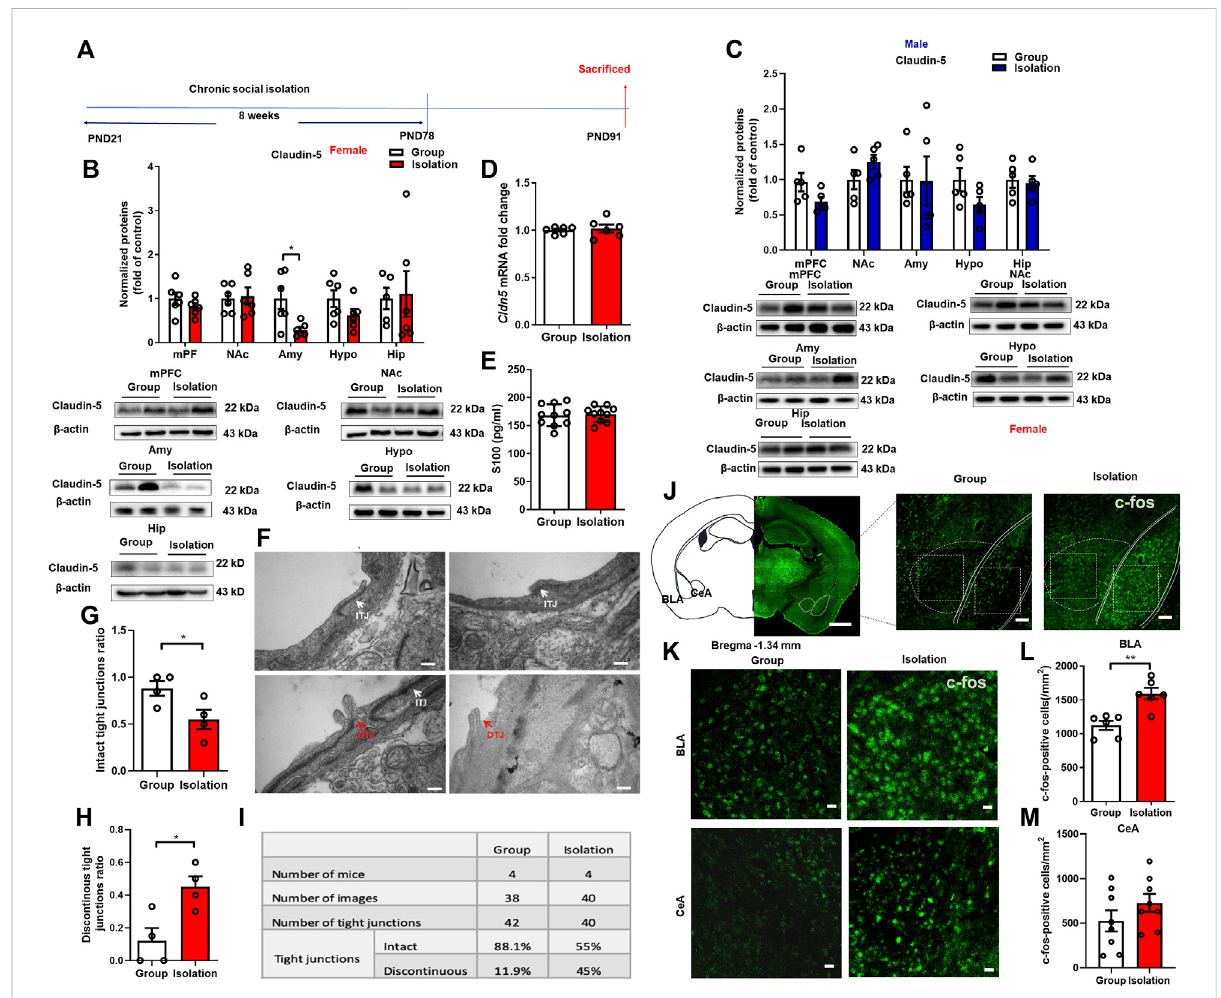
FIGURE 4 Childhood social isolation damaged BBBin amygdalain female mice. (A) Timeline of theexperimental procedure. (B) The levels of Claudin-5 in the mPFC, NAc, Amy, Hypo and Hip of female mice (red bars, n = 6) and representative immunoblots. (C) The levels of Claudin-5 in the mPFC, NAc, Amy,HypoandHipofmalemice(bluebars, n =5)andrepresentativeimmunoblots. (D) QuantitativePCRmeasurementof Cldn5 mRNA. (E) Thelevel of S100 measured by ELISA. (F) The intact tight junctions (white arrows) and discontinuous tight junctions (red arrows) measured by transmission electron microscopy.Scalebar =200 nm. (G) The intacttight junctionsratio (H) Thediscontinuous tight junctions ratio. (I) Summary of tightjunctionsintheamygdalaoffemalemice. (J) Representativeimagesofc-fosintheamygdala(BLAandCeA).Scalebar=1 mm(locationdiagram of amygdala) and 100 μ m (partial schematic diagram). (K) Representative images of c-fos immuno fl uorescence staining in BLA and CeA, scale bar = 20 μ m. (L,M) Quantitative assay of c-fos positive cells in BLA and CeA, n = 3. Data were mean ± SEM, * p < 0.05, ** p < 0.01. mPFC, medial prefrontal cortex; NAc, nucleus accumbens; Amy, amygdala; Hypo, hypothalamus; Hip,